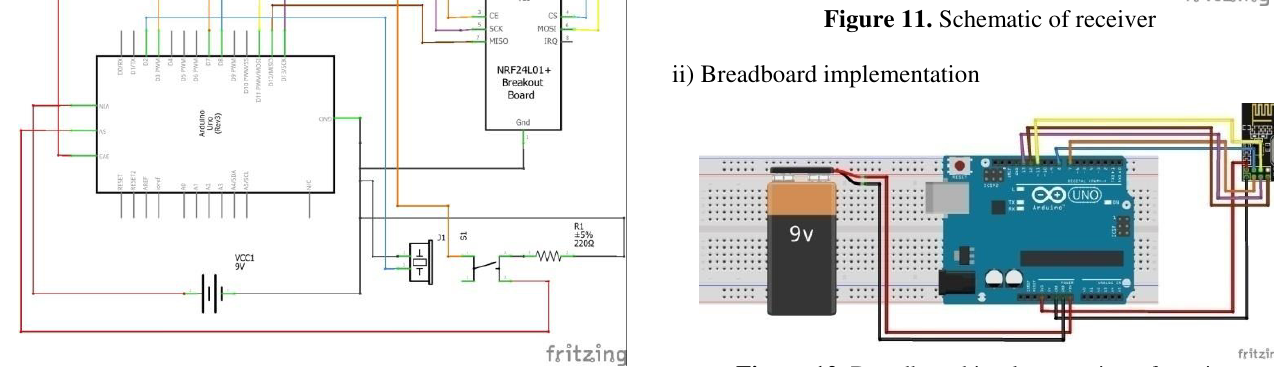
Figure 9. Schematic of transmitter